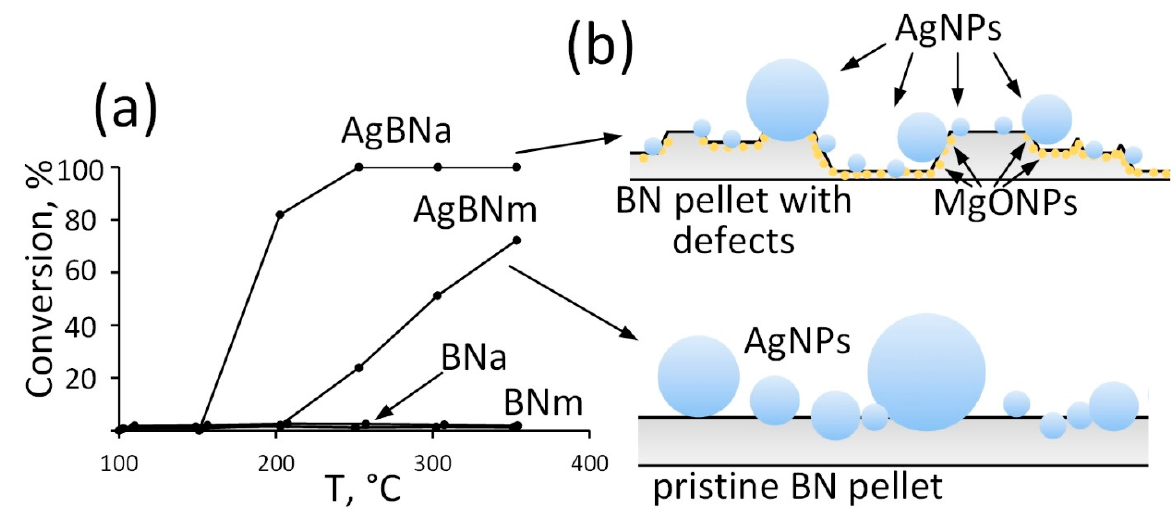
Figure 6. CO conversion ( a ) and schematic structure illustration ( b ).